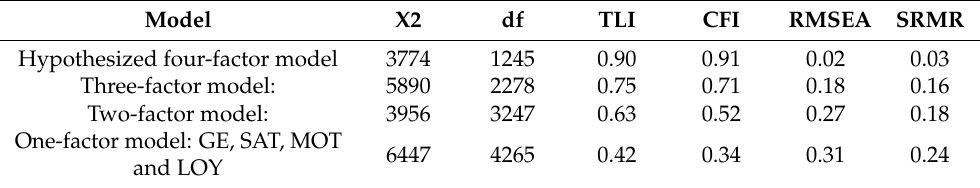
Table 5. Verification of the